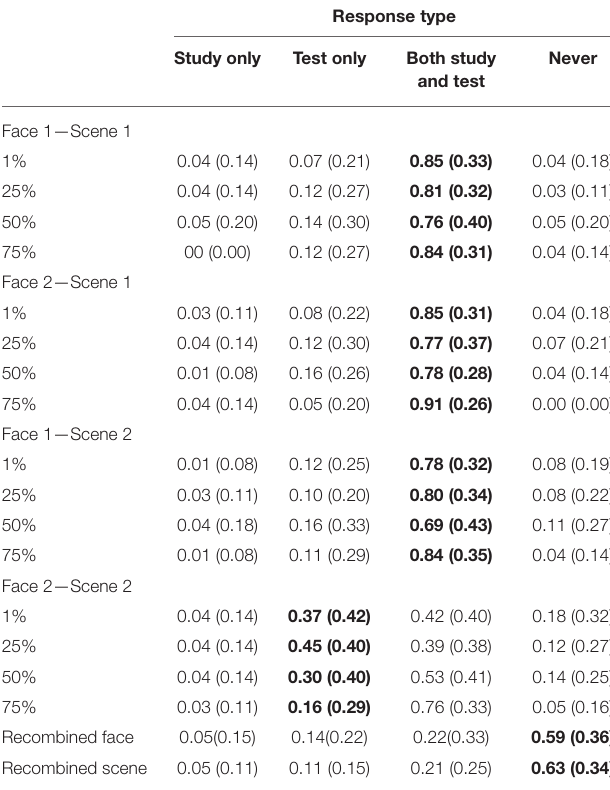
TABLE 3 | Experiment 2 source memory responses separated by shared parent blend level and trial